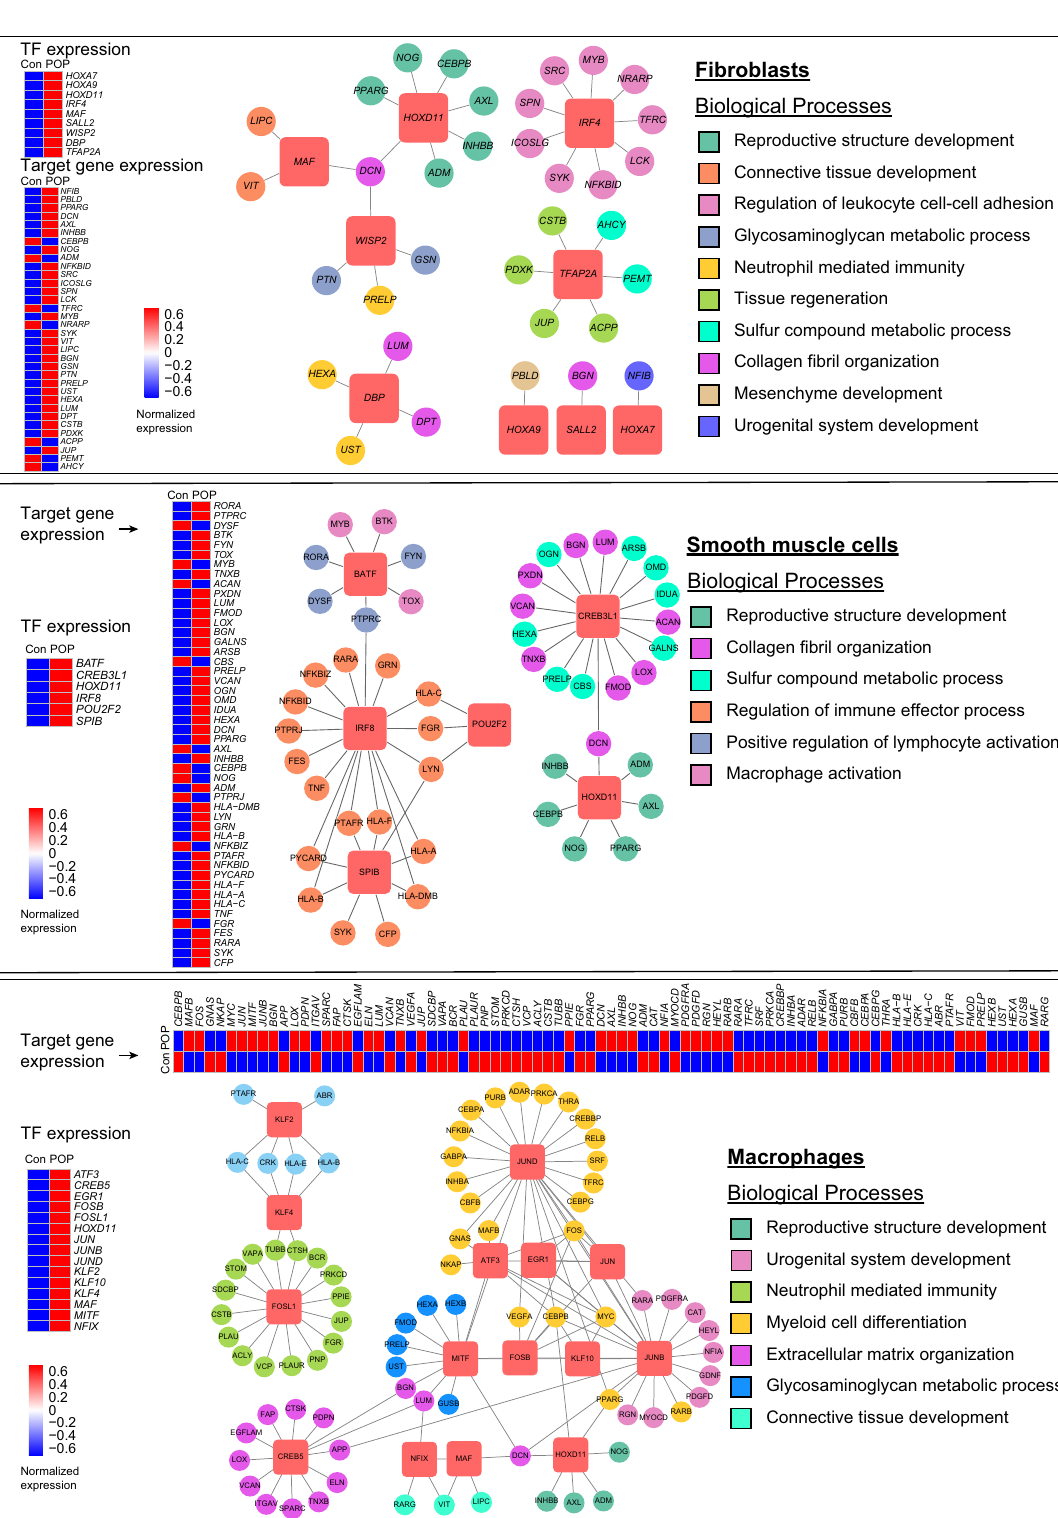
NATURE COMMUNICATIONS| (2021) 12:87